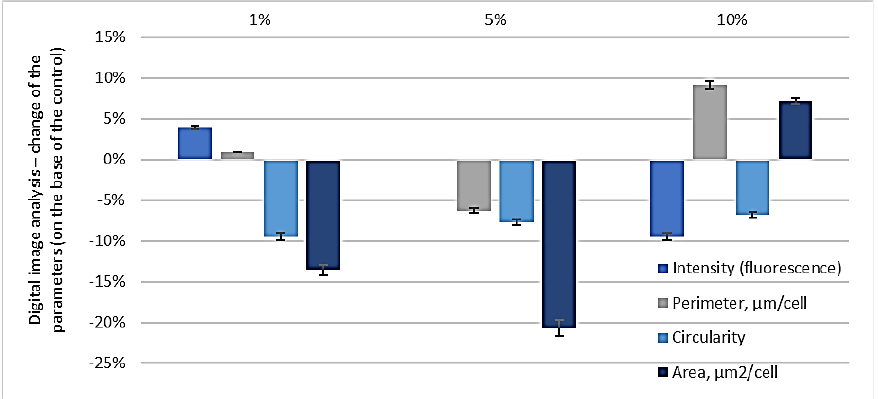
Figure 10. Changes in the fluorescence intensity, parameters of the cells, circularity, and area of E. coli cells compared to the control after incubation with different concentrations (1%, 5%, 10%) of the peptide fraction with MW below 10 kDa or 6 h.